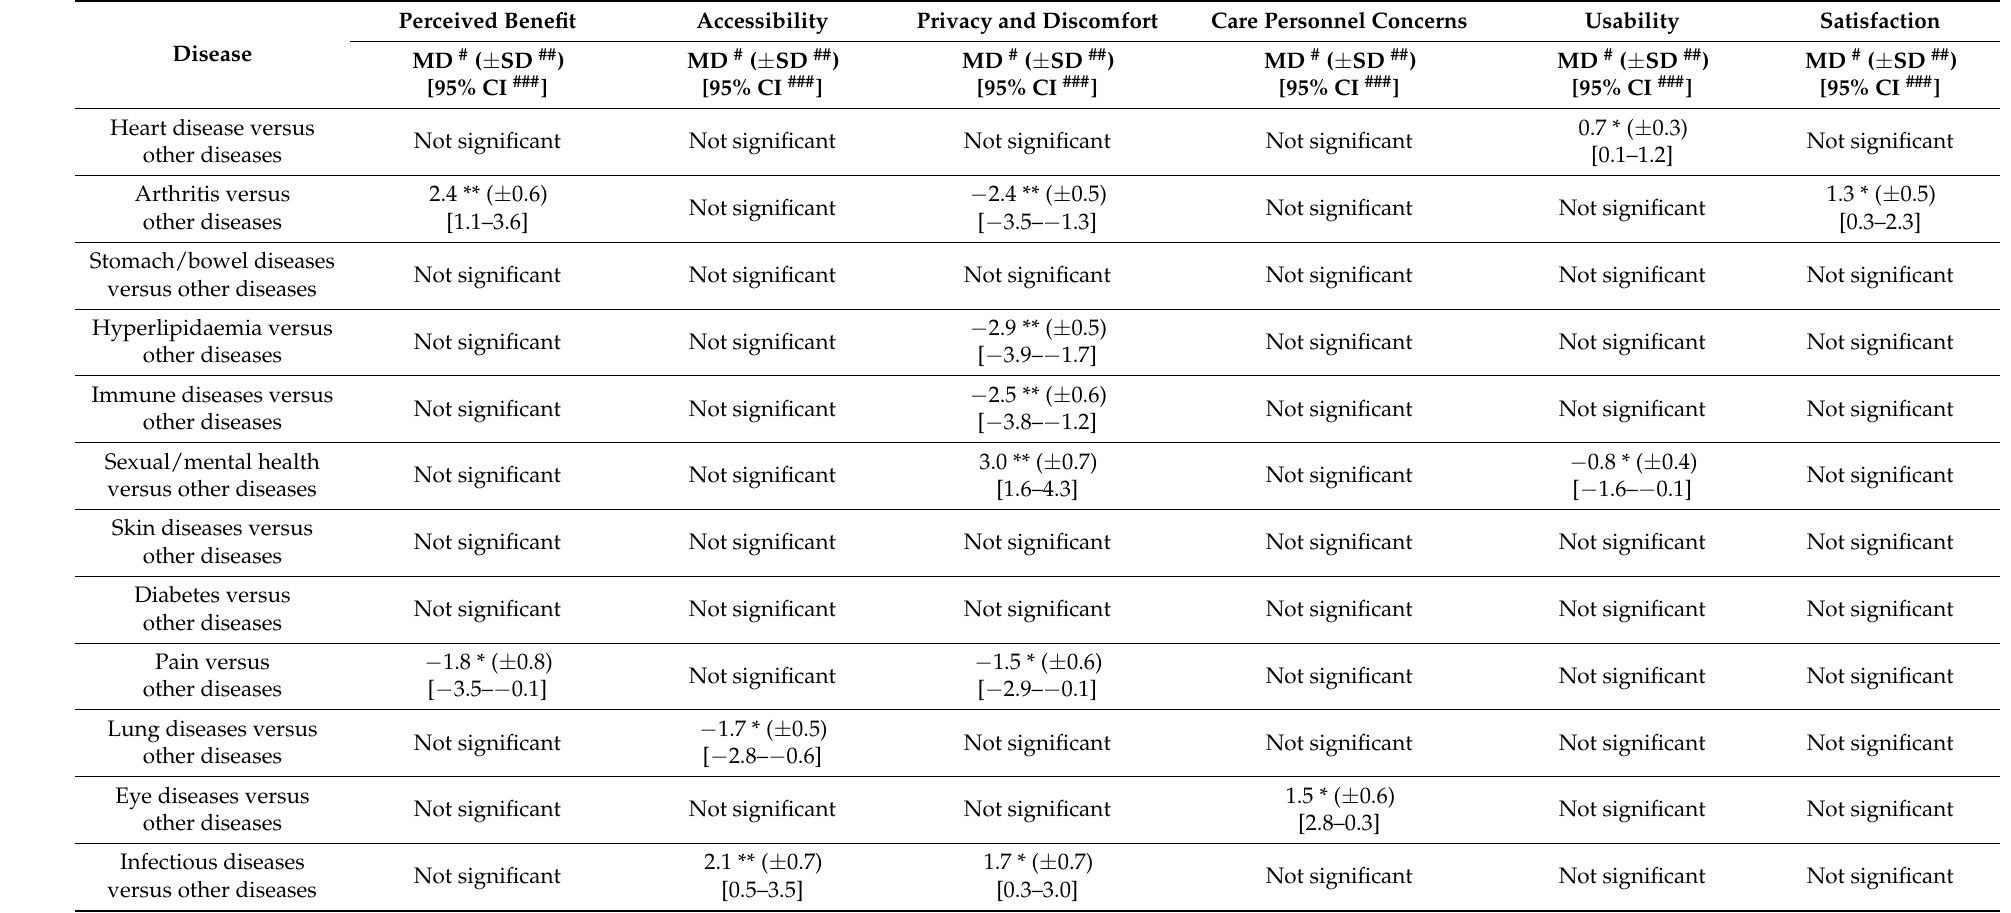
Table 5. Comparison of different domains of telemedicine use across different types of diseases ( n =